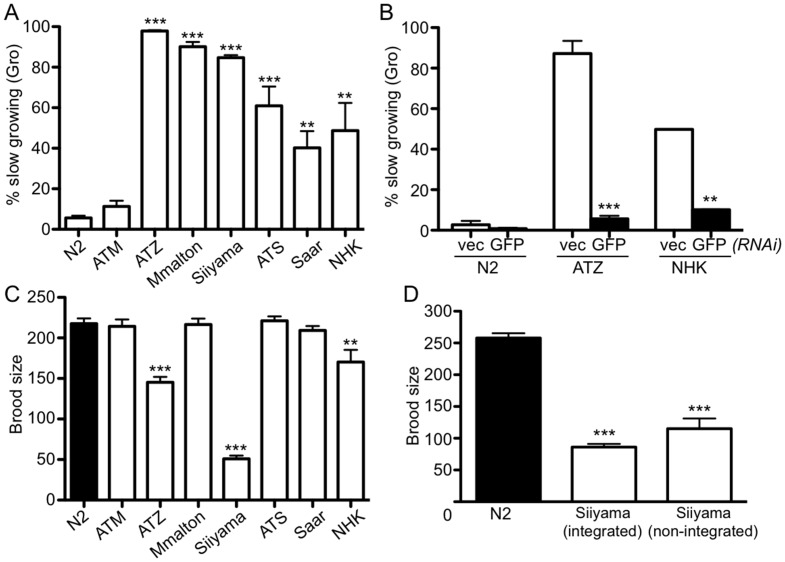
Effect of AT variant protein expression on larval growth and brood sizes.Assessment of slow growth (Gro) phenotype during post-embryonic development (A). Statistical significance was determined comparing Gro phenotypes of AT variants to wild-type ATM-expressing lines using an unpaired, two-tailed students t-test. Reversal of Gro phenotype by GFP(RNAi) (B). Statistical significance was determined by comparing treatments to their respective vec(RNAi) controls using an unpaired, two-tailed students t-test. Brood size assessment of AT variant lines (C). Statistical significance was determined comparing brood size of AT variants compared to wild-type ATM-expressing lines using an unpaired, two-tailed students t-test. Brood size comparison between integrated and non-integrated Siiyama expressing lines (D). Statistical significance was determined comparing brood size of AT variants was compared to wild-type ATM-expressing lines using an unpaired, two-tailed students t-test. In all experiments, the probabilities of results were reported as *P<0.05, **P<0.01, or ***P<0.001.